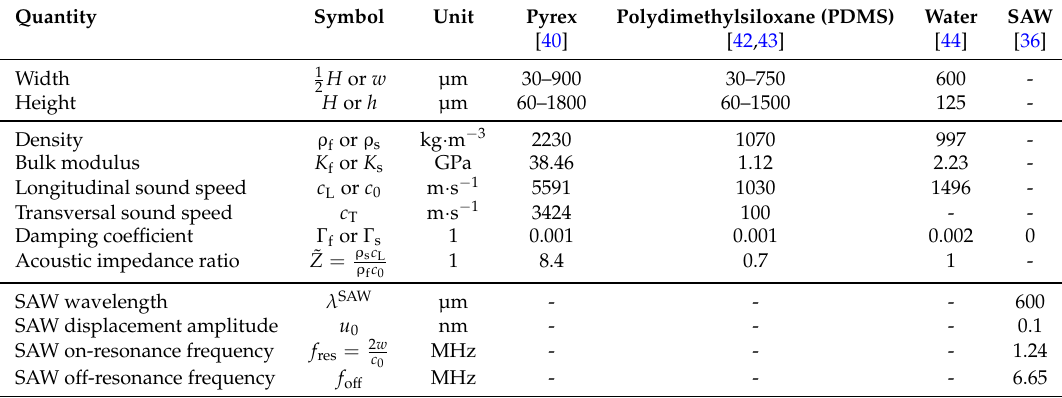
Table 2. List of parameters used for geometry, materials, and surface acoustic waves (SAW) in the numerical model. The values for the damping paramters Γ are from Reference